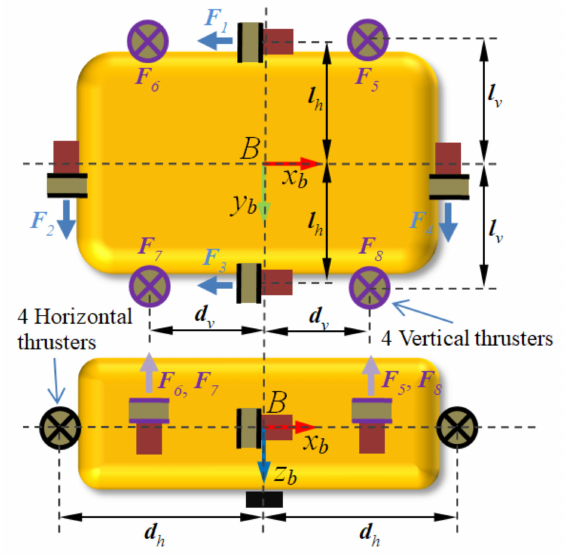
Figure 3. Layout of thrusters of the